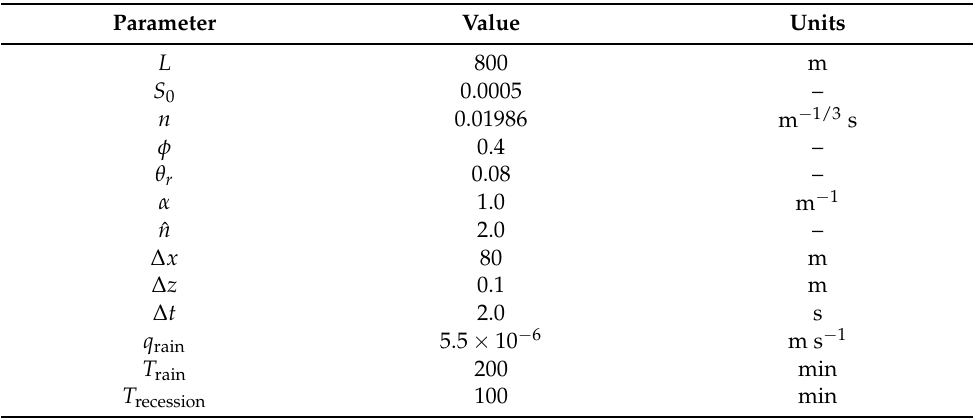
Table 1. Common parameters for test of rainfall on a sloping plane.